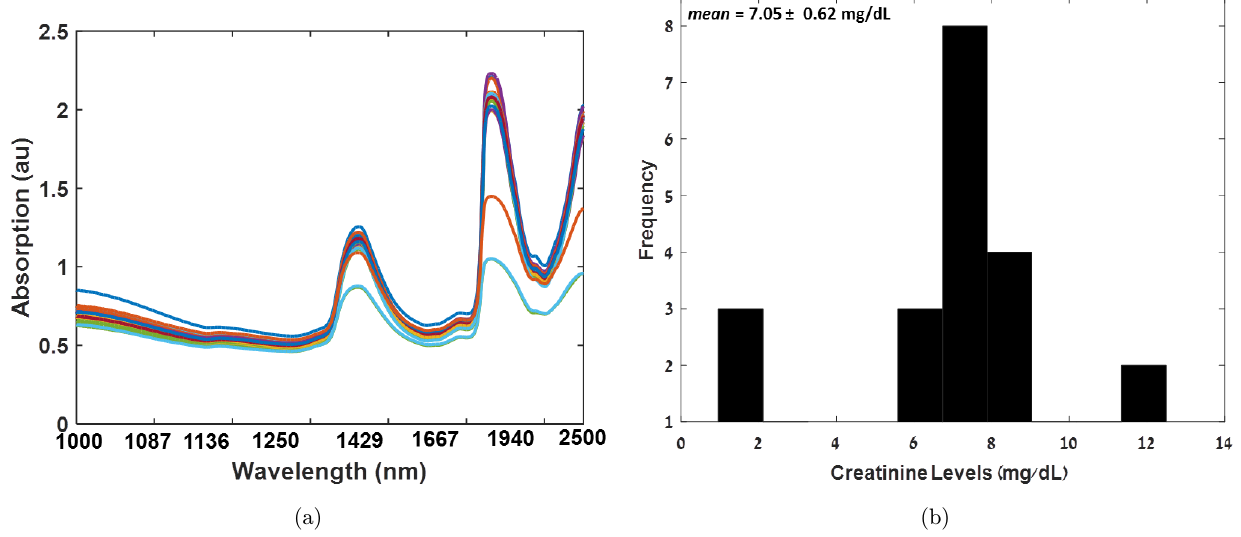
Fig. 2. (a) Measured NIR absorption spectra of whole blood with varied Cr concentrations measured by the FT-NIR spectrometer and (b) Histogram showing the distribution of concentrations of Cr in this work. The mean and standard error of 7.05 and 0.62, respectively are given.